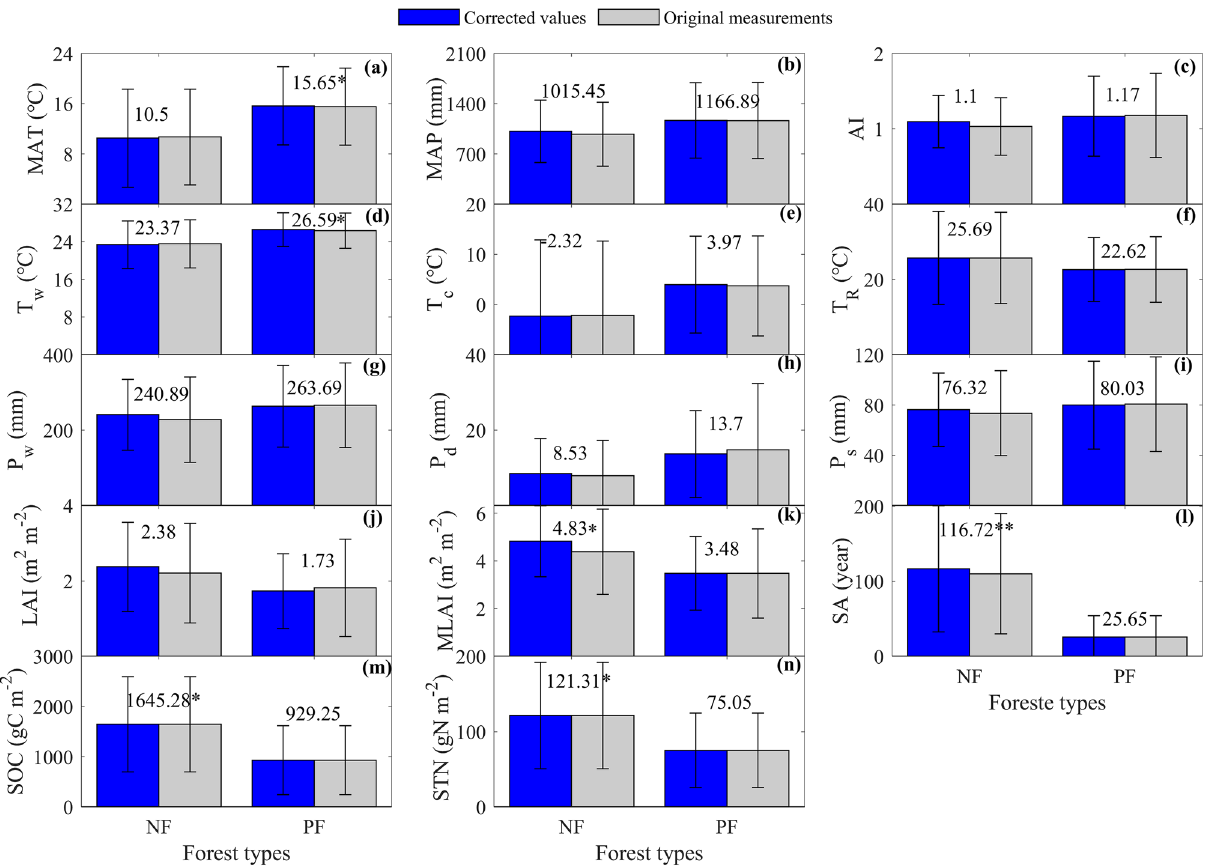
Figure 1. The differences in environmental factors between naturally regenerating forests (NF) and planted forests (PF) in China. The environmental factors include three annual climatic factors ( a – c ), three seasonal temperature factors ( d – f ), three seasonal precipitation factors ( g – i ), three biotic factors ( j – l ), and two soil factors ( m , n ). Three annual climatic factors include mean annual air temperature (MAT, a ), mean annual precipitation (MAP, b ), and aridity index (AI, c ) defined as the ratio of MAP to annual potential evapotranspiration. Three seasonal temperature factors include the temperature of the warmest month (T w , d ), the temperature of the coldest month (T c , e ), temperature annual range (T R , f ). Three seasonal precipitation factors include precipitation of the wettest month (P w , g ), precipitation of the driest month (P d , h), and precipitation seasonality (Ps, i ) defined as the standard deviation of monthly precipitation during the measuring year. Three biological factors include the mean annual leaf area index (LAI, j ), the maximum leaf area index (MLAI, k ), and stand age (SA, l ). Two soil factors include soil organic carbon content (SOC, m ) and soil total nitrogen content (STN, n ). The differences are tested for each variable with one-way analysis of variance (ANOVA), where * and ** indicate significant differences between forest types at significance levels of α = 0.05 and α = 0.01, respectively. The corrected values are mean values during 2003–2019 after correcting the original measurements with the interannual trend (See methods), which are listed in each panel, while original measurements are mean values during the measuring period of each ecosystem, which are not shown in each